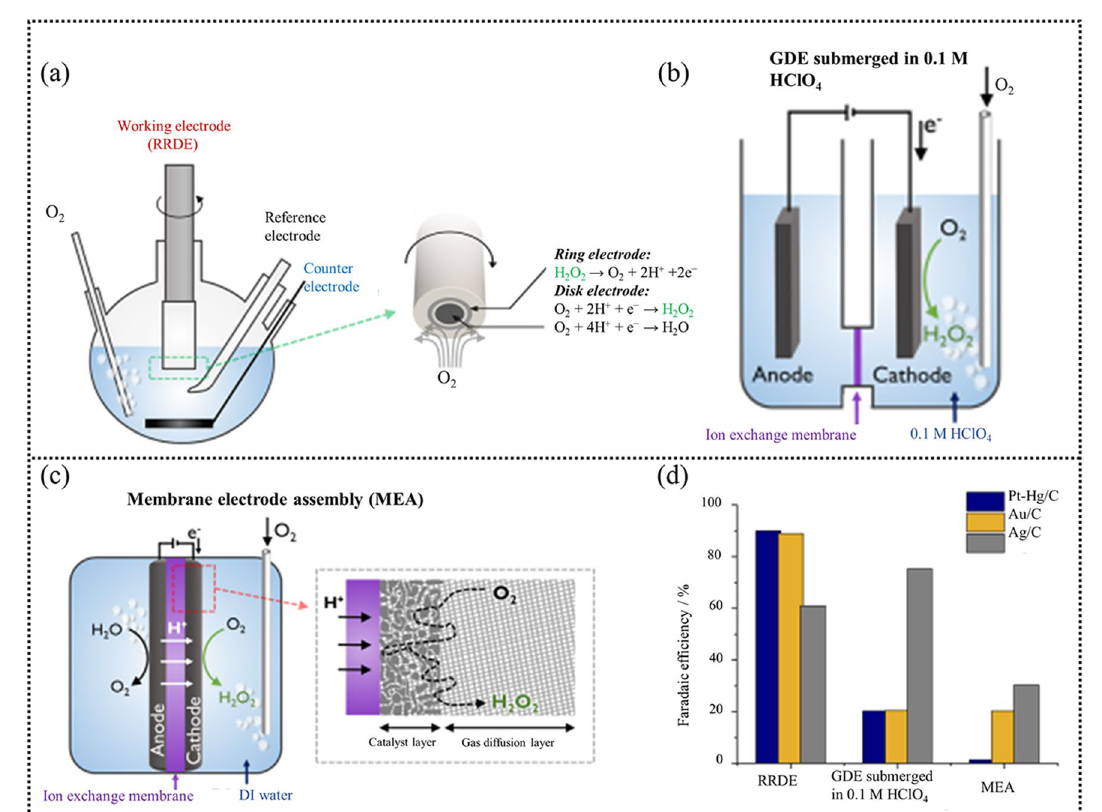
Fig. 4 a Schematic of a RRDE setup. b GDE submerged in 0.1 M HClO 4 . c MEA using a three-electrode system. d Faradaic efficiency in vari- ous laboratory-scale electrochemical cells for